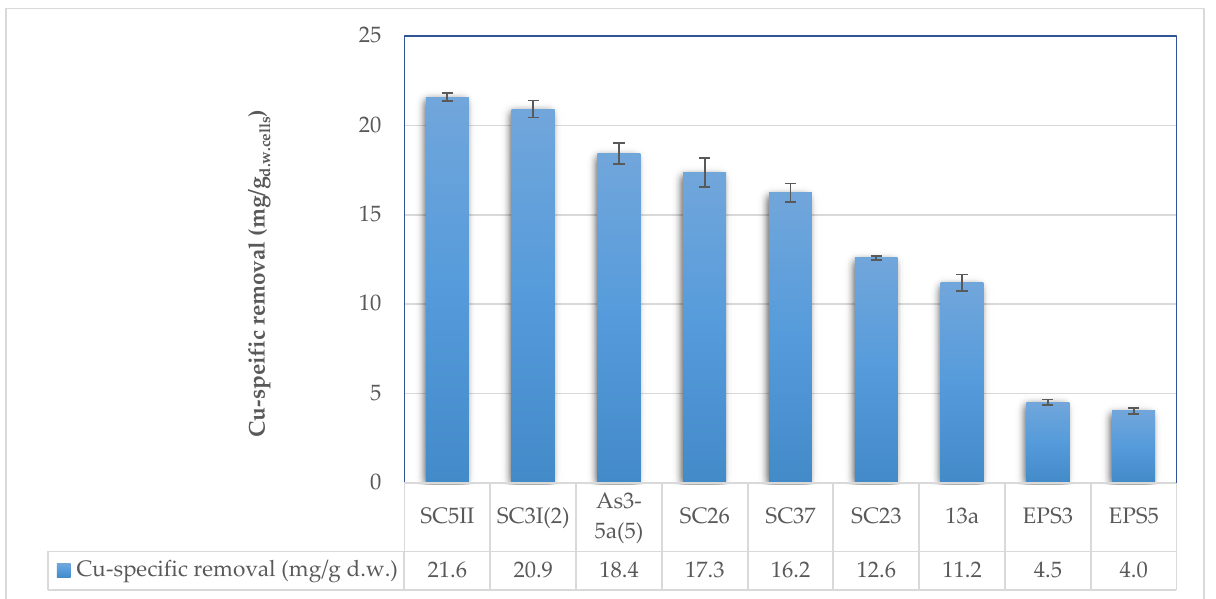
Figure 1. Cu-specific removal (mg/g d.w.) by bacterial isolates in filter-adsorbed biomass trials.